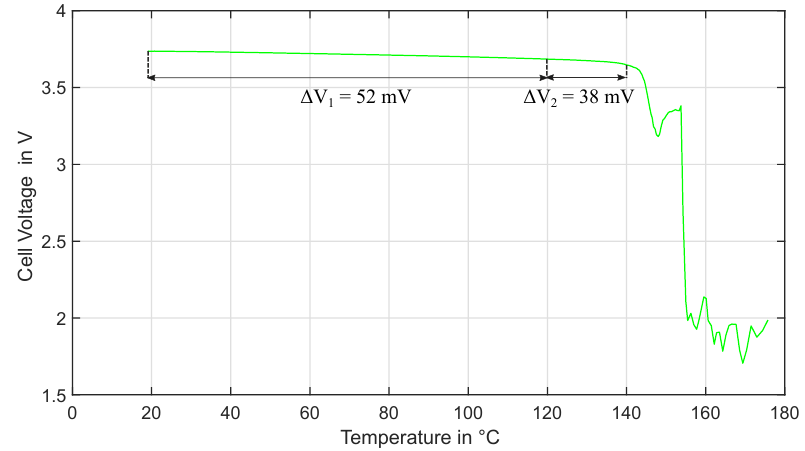
Figure 9. Experiment HT1: Cell voltage curve as a function of cell